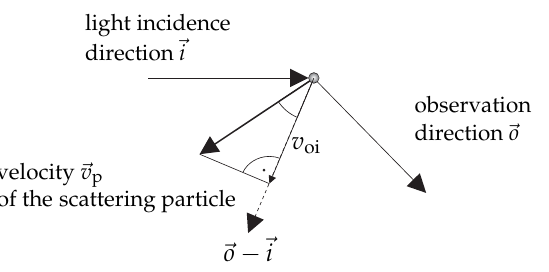
Figure 2. Measurement arrangement of Doppler principles illustrated for the light scattering on a single particle (measurement of one velocity component, acceleration neglected).